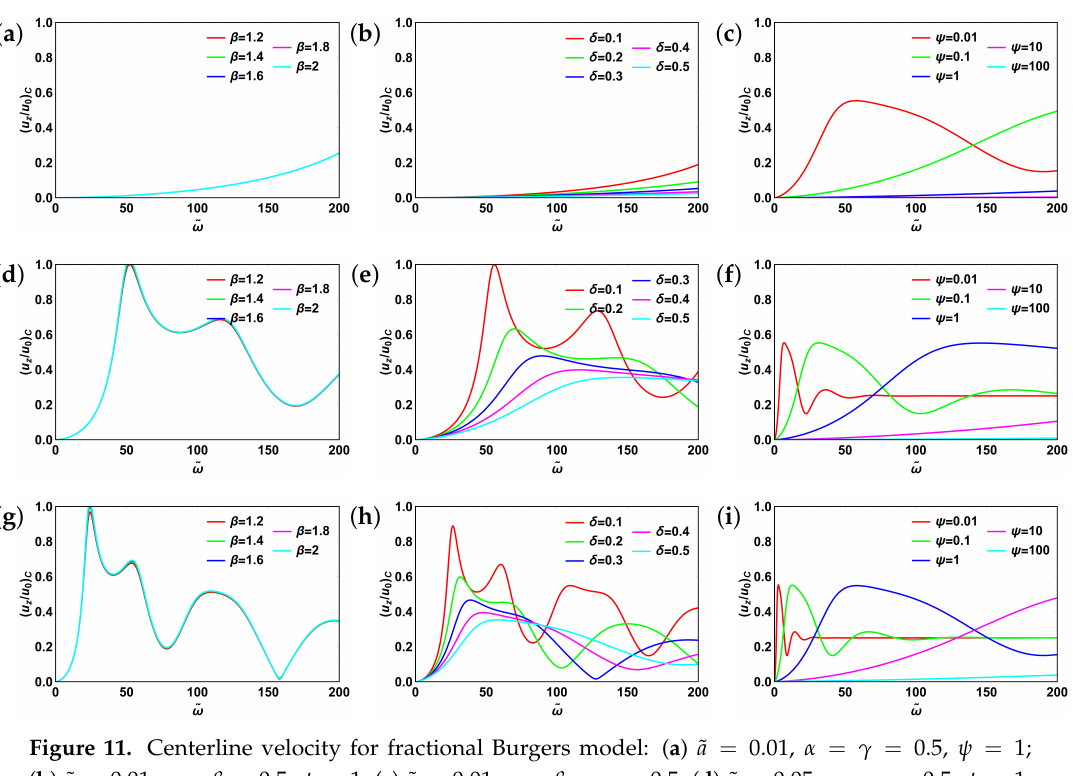
Figure 11. Centerline velocity for fractional Burgers model: ( a ) ˜ a = 0.01, α = γ = 0.5, ψ =